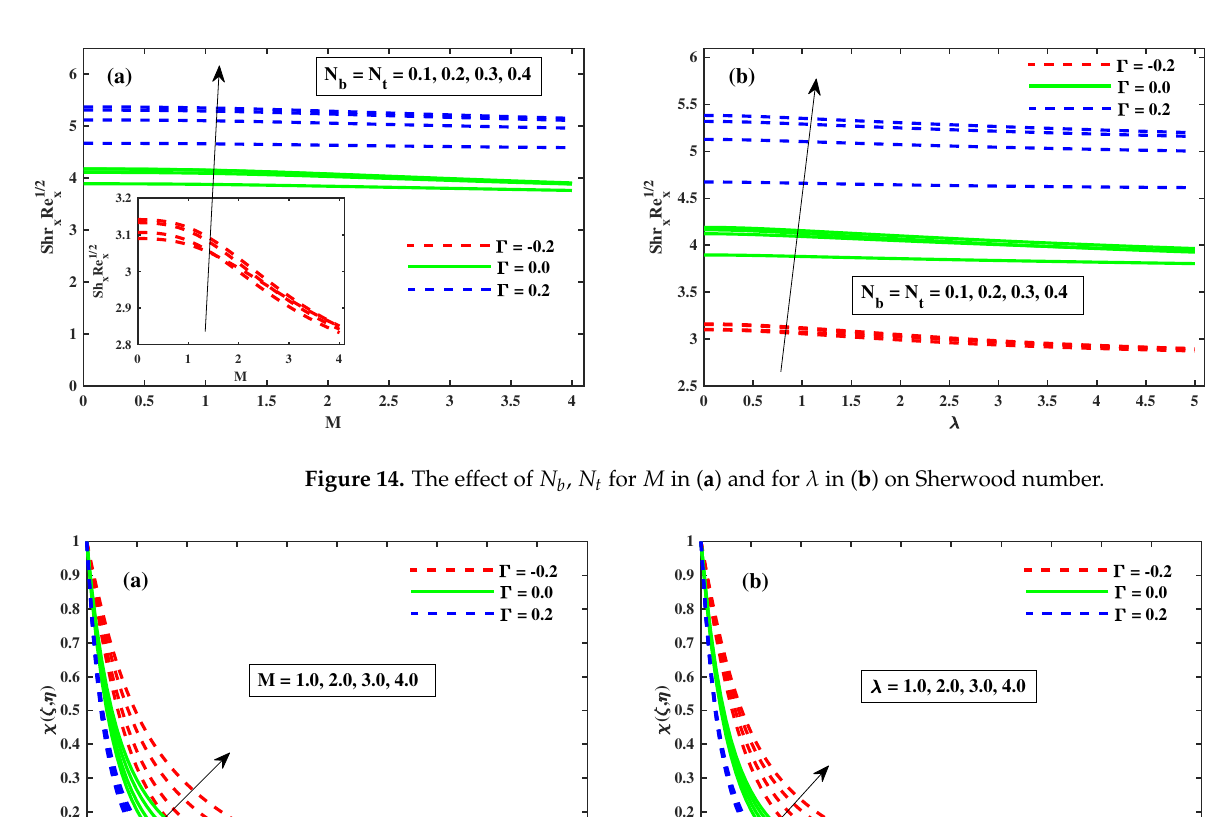
Figure 13. The variation in Φ ( ζ , η ) against Le in ( a ) and for β in ( b ).